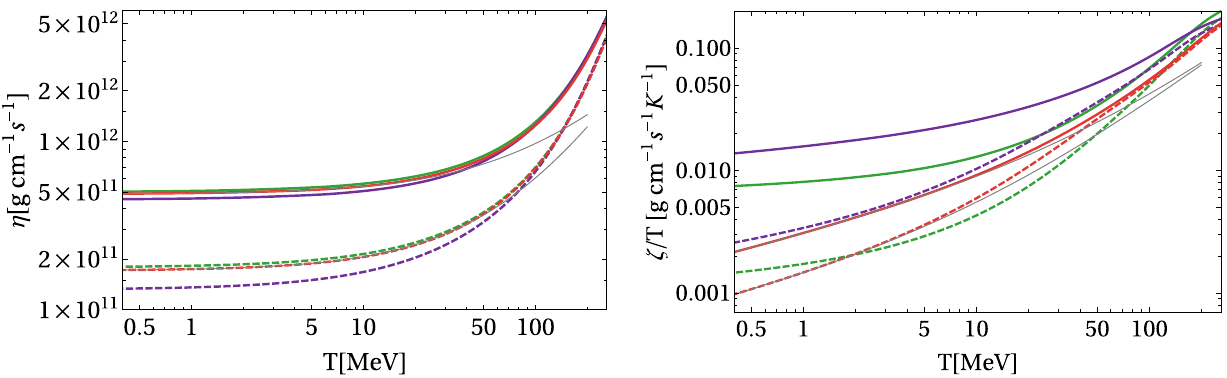
Fig. 12 The shear viscosity (left) and bulk viscosity divided by temperature (right) as a function of temperature. Dashed (solid) curves are for μ = 450 MeV ( μ = 600 MeV). Green, red, and violet curves use potentials 5b, 7a, and 8b, respectively. The thin gray curves are given by B B transseries fits to the 7a